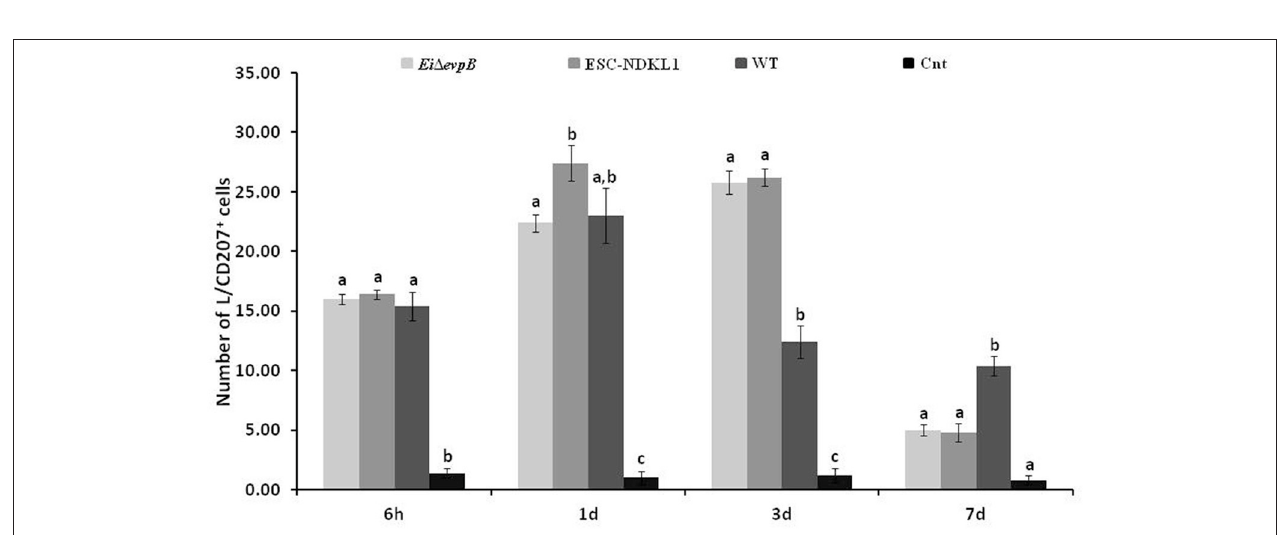
FIGURE 6 | The kinetics of L/CD207 + cells numbers in the gills of catfish challenged with E. ictaluri LAV and WT strains. Different letters (a, b, and c) show the significant differences between groups at each time point ( P < 0.05). The data represent the mean of cell numbers in five fish gills ± SD.